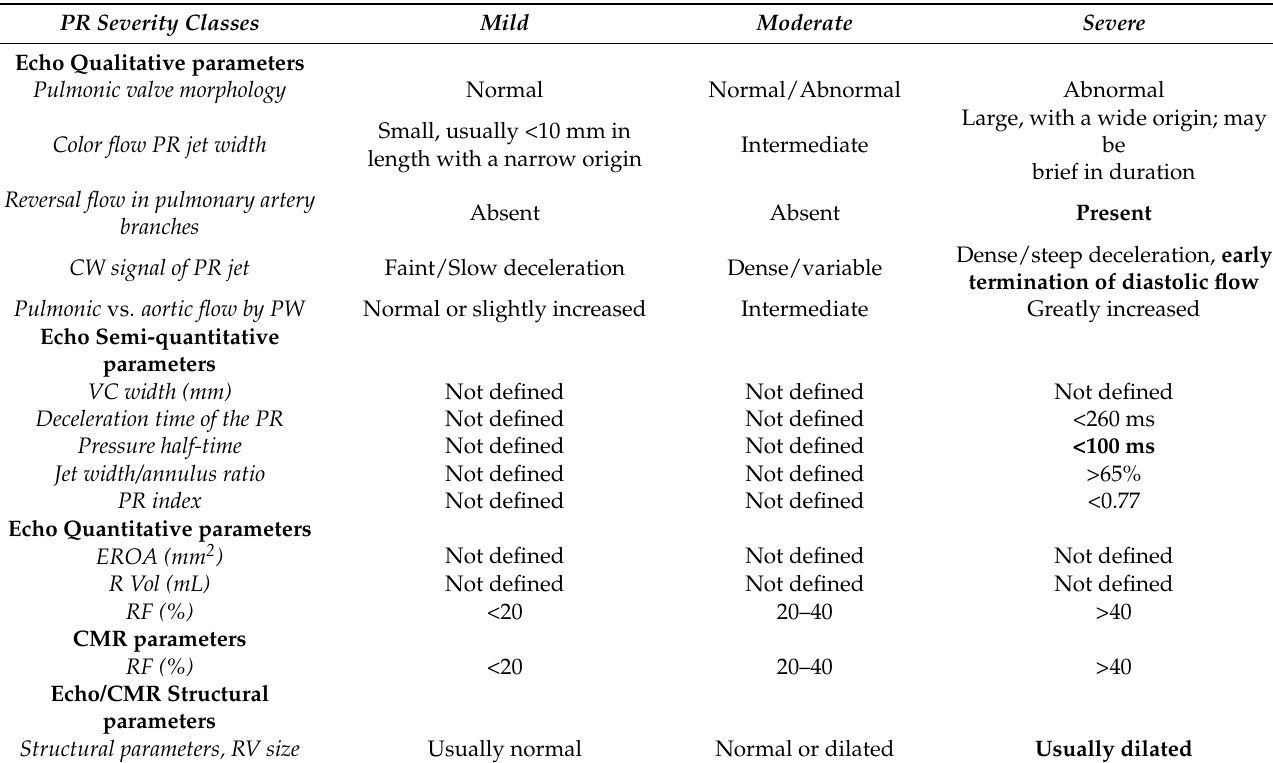
Table 2. Grading the severity of pulmonary regurgitation using echocardiography and cardiac magnetic